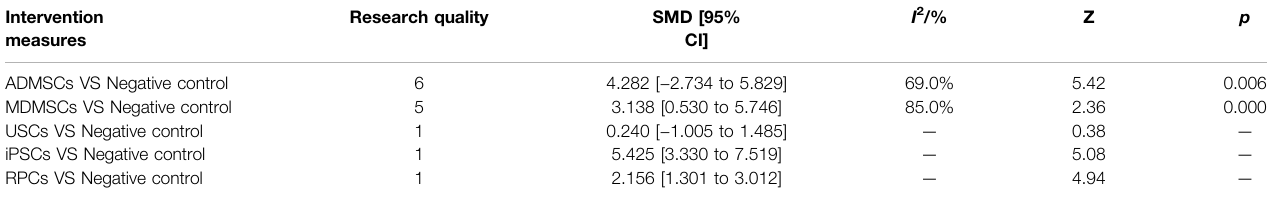
TABLE 15 | Traditional Meta-analysis results of proliferation of resident cells between stem cell groups and the control group in early stage after administration. Intervention measures